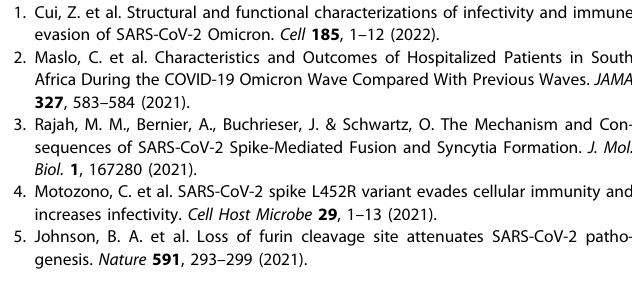
Fig. 1 The Omicron-L452R variant increases fusogenicity, infectivity and host glycolysis. a The cumulative cases of SARS-CoV-2 virus mutations based on data deposited in the GISAID database from January 2020 to January 2022. b Global distribution of SARS-CoV-2 virus mutations as of January 2022. c Schematic diagram of the spike mutations of the parental (B.1), Delta, Omicron, and Omicron-L452R variants. d Representative images of syncytium formation with the indicated GFP-spike proteins in Huh-7 and hACE2 stably transfected 293T and H1299 cells. The graphs in the right panel show the relative fusion. The results shown are the mean ± SD of three independent experiments. Scale bar, 200 μ m. e Western blot analysis of SARS-CoV-2 spike cleavage of the indicated variant pseudoviruses in 293T cells stably transfected with hACE2. β -actin was used as a loading control. The densitometry of cleavage was analyzed with Image J. The results shown are the mean ± SD of three independent experiments. f Pseudovirus entry of B.1, Delta, the Omicron-L452R variants in Huh-7 cells and 293T and H1299 cells stably transfected with ACE2. Pseudovirus entry was quanti fi ed by measuring the luciferase activity in the cell lysates at the indicated times after infection. Fold changes in the luciferase signal were normalized to uninfected cells. The results shown are the mean ± SD of three independent experiments. * P < 0.05, ** P < 0.01. g Lactate production assay in Huh-7 cells, ACE2 stably transfected 293T and H1299 cells infected with B.1, Delta, the Omicron-L452R variant pseudoviruses. The results shown are the mean ± SD of three independent experiments. * P < 0.05, ** P < 0.01. h Extracellular acidi fi cation rate (ECAR) analysis of glycolysis (following glucose injection), glycolytic capacity (following oligomycin injection), and glycolytic reserve (glycolytic capacity; glycolysis) in Huh-7 cells and ACE2 stably transfected 293T and H1299 cells infected with B.1, Delta, Omicron and the Omicron-L452R variant pseudoviruses. The results shown are the mean ± SD of three independent experiments. * P < 0.05, ** P < 0.01. i Representative bioluminescence image at 2 days of K18-hACE2 transgenic mice injected with the indicated pseudovirus through the tail vein (2 × 10 6 TCID50 per mouse). The luminescence signal is represented by an overlaid false-color image with the signal intensity indicated by the scale (right panel) ( n = 4). j qRT – PCR analysis of virus copies in infected mouse lung tissues from ( i ). The results shown are the mean ± SD of three independent experiments. * P < 0.05, ** P <